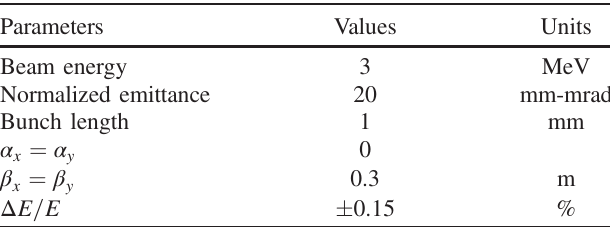
TABLE V. Beam parameters at the buncher exit.